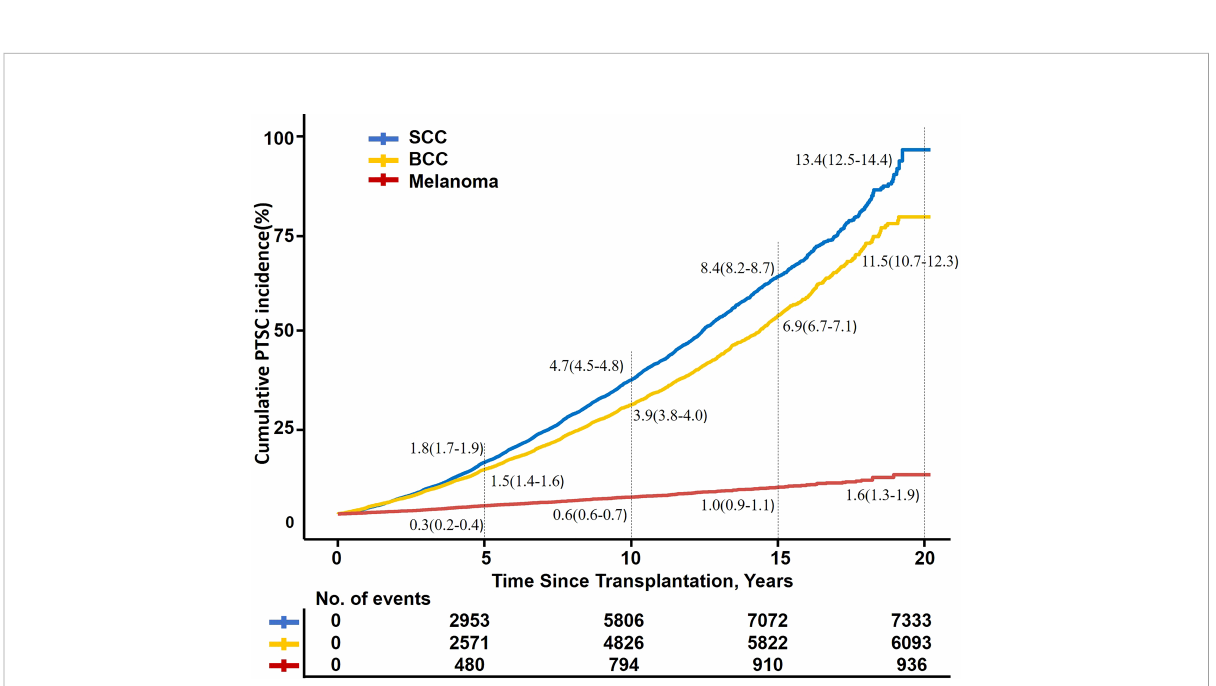
FIGURE 3 Kaplan – Meier fi t of PTSC incidence by time after transplantation. SCC, squamous cell carcinoma; BCC, basal cell carcinoma; PTSC, posttransplant skin cancer.